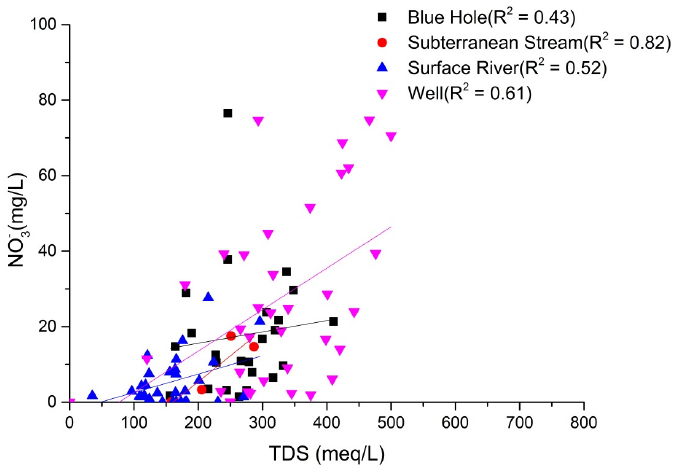
Figure 5. Relationship between NO 3 − and total dissolved solids (TDS) in groundwater of the Huixian karst wetland.